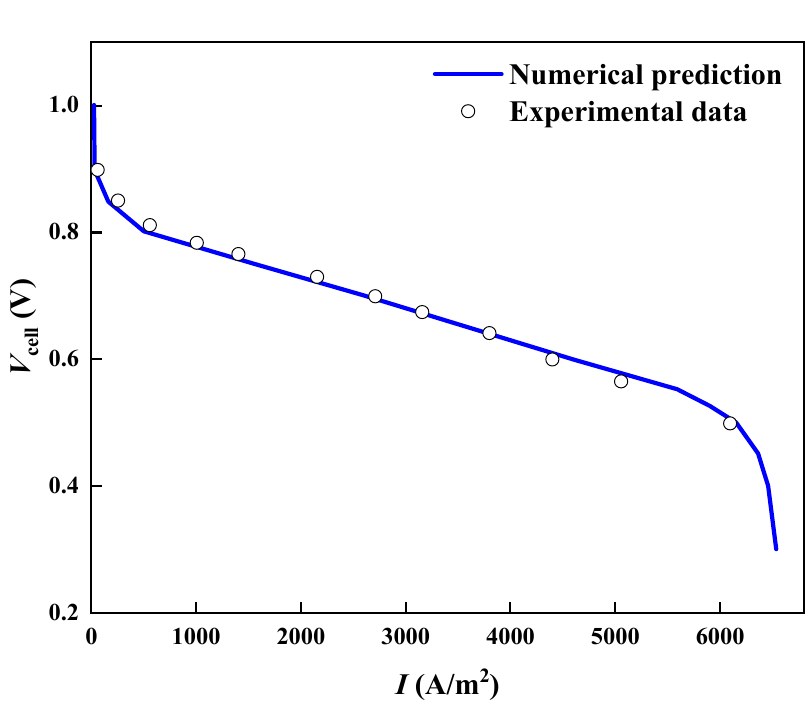
Figure 2. Model Figure 2. Model validation.